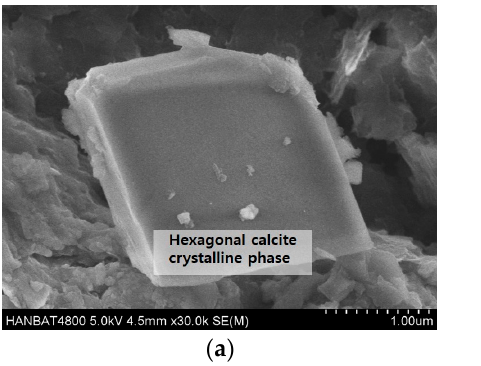
Figure 9. SEM images of calcite precipitated in the co-culture medium at magnification of: ( a ) 30,000; and ( b ) 7000.